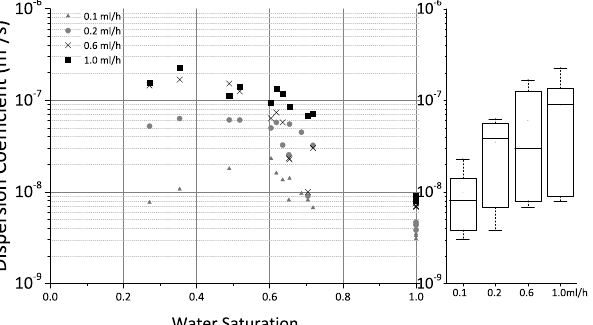
Figure 1. Left: Dispersion coefficient versus saturation. Right: variation of dispersion coefficient versus flow